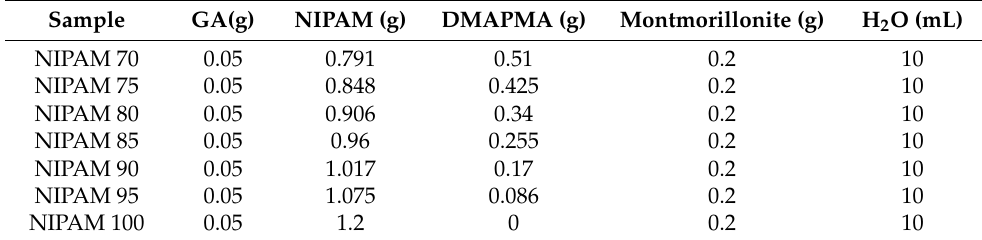
Table 1. GA–P(NIPAM-co-DMAPMA) hydrogel experimental